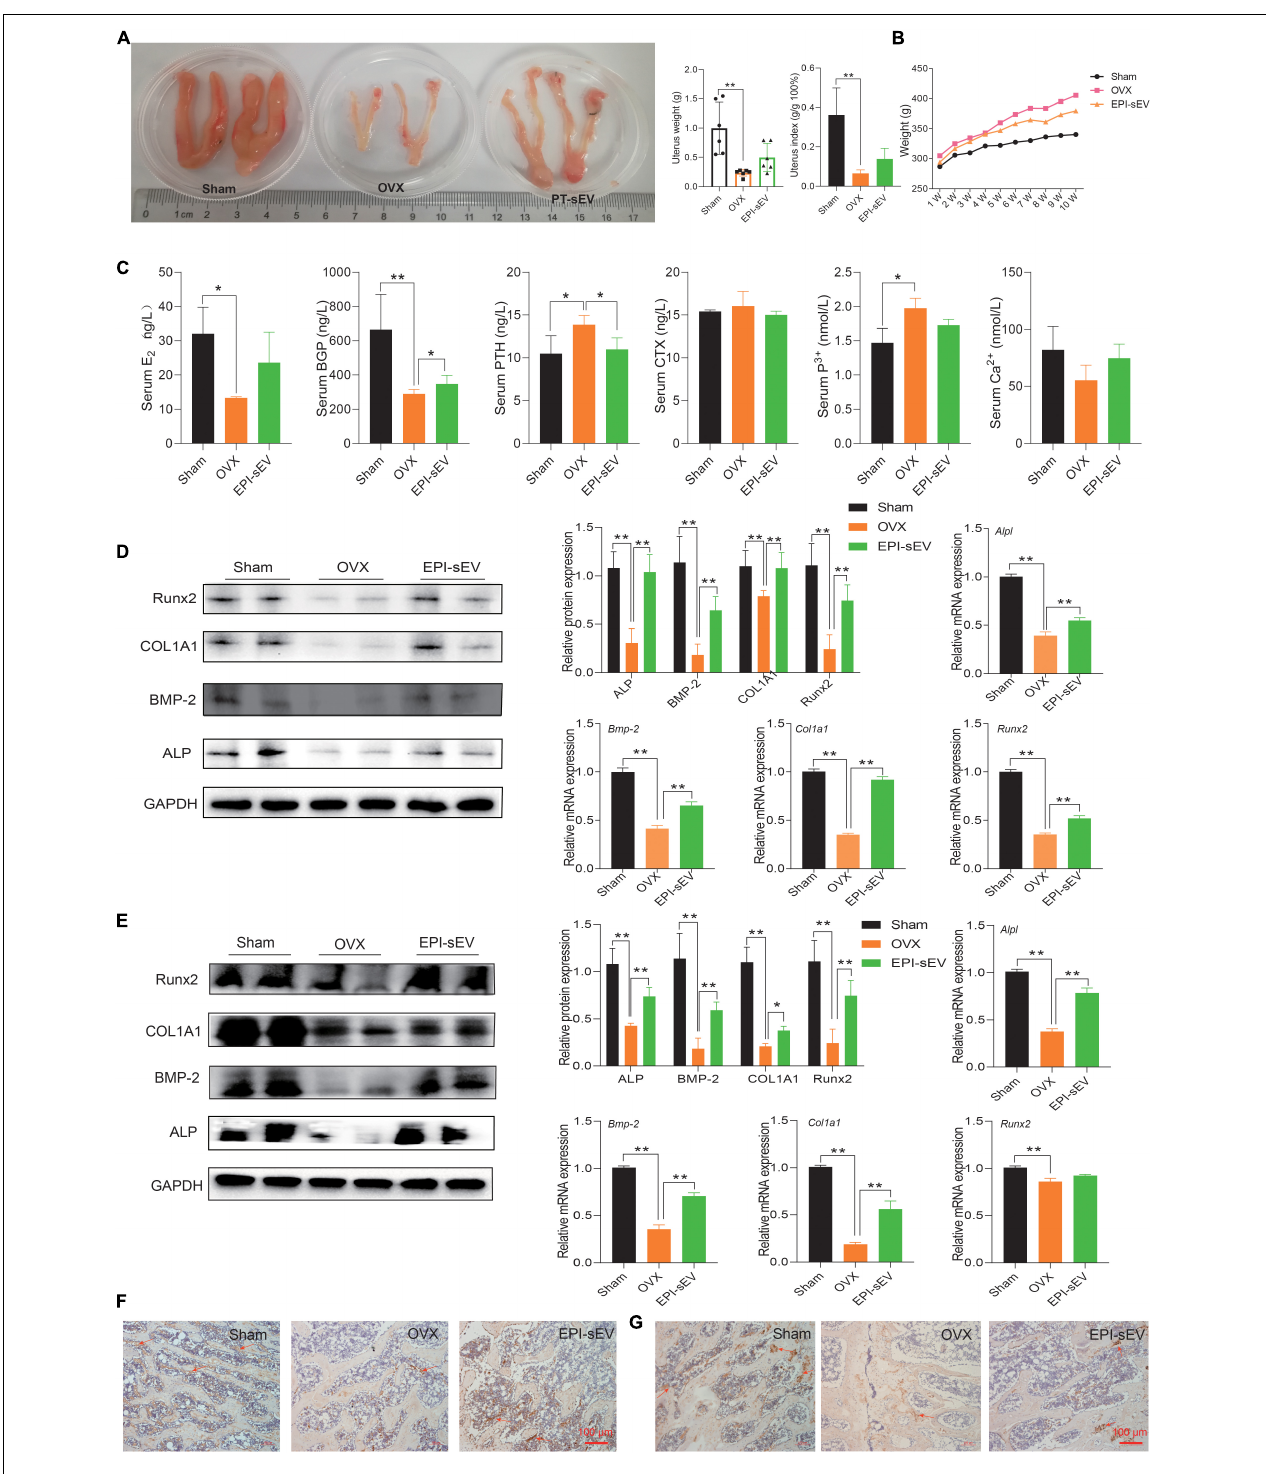
FIGURE 4 | EPI-sEV regulates the expression of bone turnover markers and promotes bone formation in OVX rats. (A) The morphology, weight, and index of the uterus in different groups ( n = 6); the raw data represented the replicate value. (B) Variation of weight in different groups ( n = 6); the raw data represented the replicate value. (C) Expression of bone turnover markers in the serum ( n = 4); the raw data represented the replicate value. (D) Protein and mRNA expression of osteogenesis-related factors in the femur; the normalized data represented mean ± SD. (E,F) Immunohistochemistry results for COL1A1 in the femur; scale bar: 100 µ m. (G) Immunohistochemistry results for COL1A1 in the lumbar vertebrae; scale bar: 100 µ m. * p < 0.05, ** p < 0.01; ns, non-significant; analyses were performed twice and obtained comparable results.